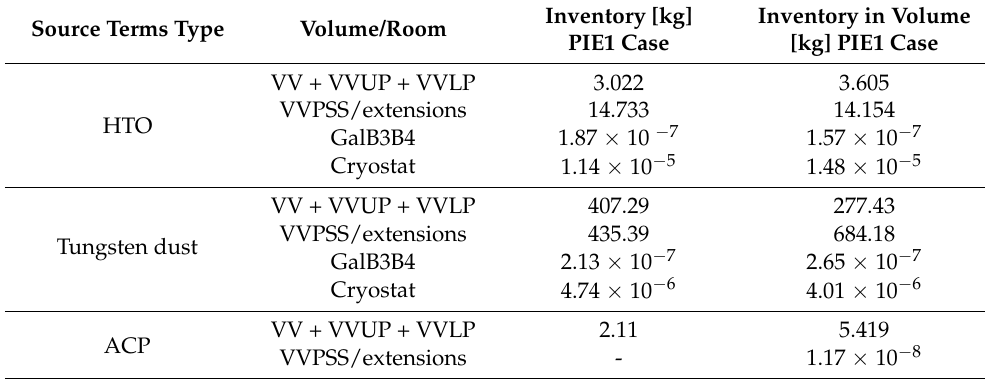
Table 4. Source terms mobilization at 32 h for considered accident